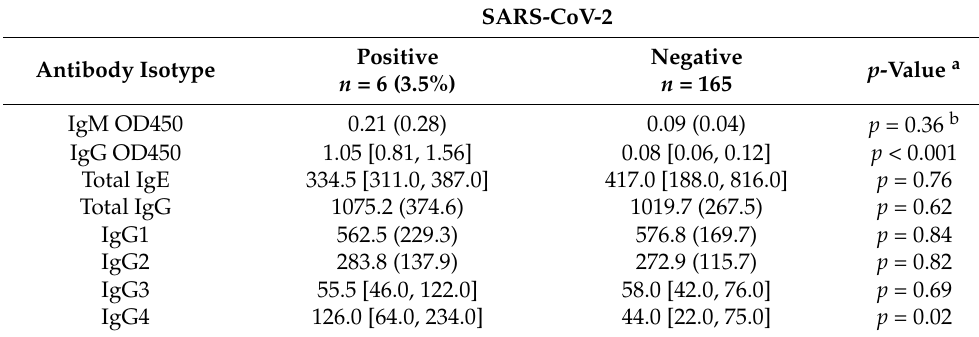
Table 2. Immune response parameters described in relation to positive SARS-CoV-2 status.